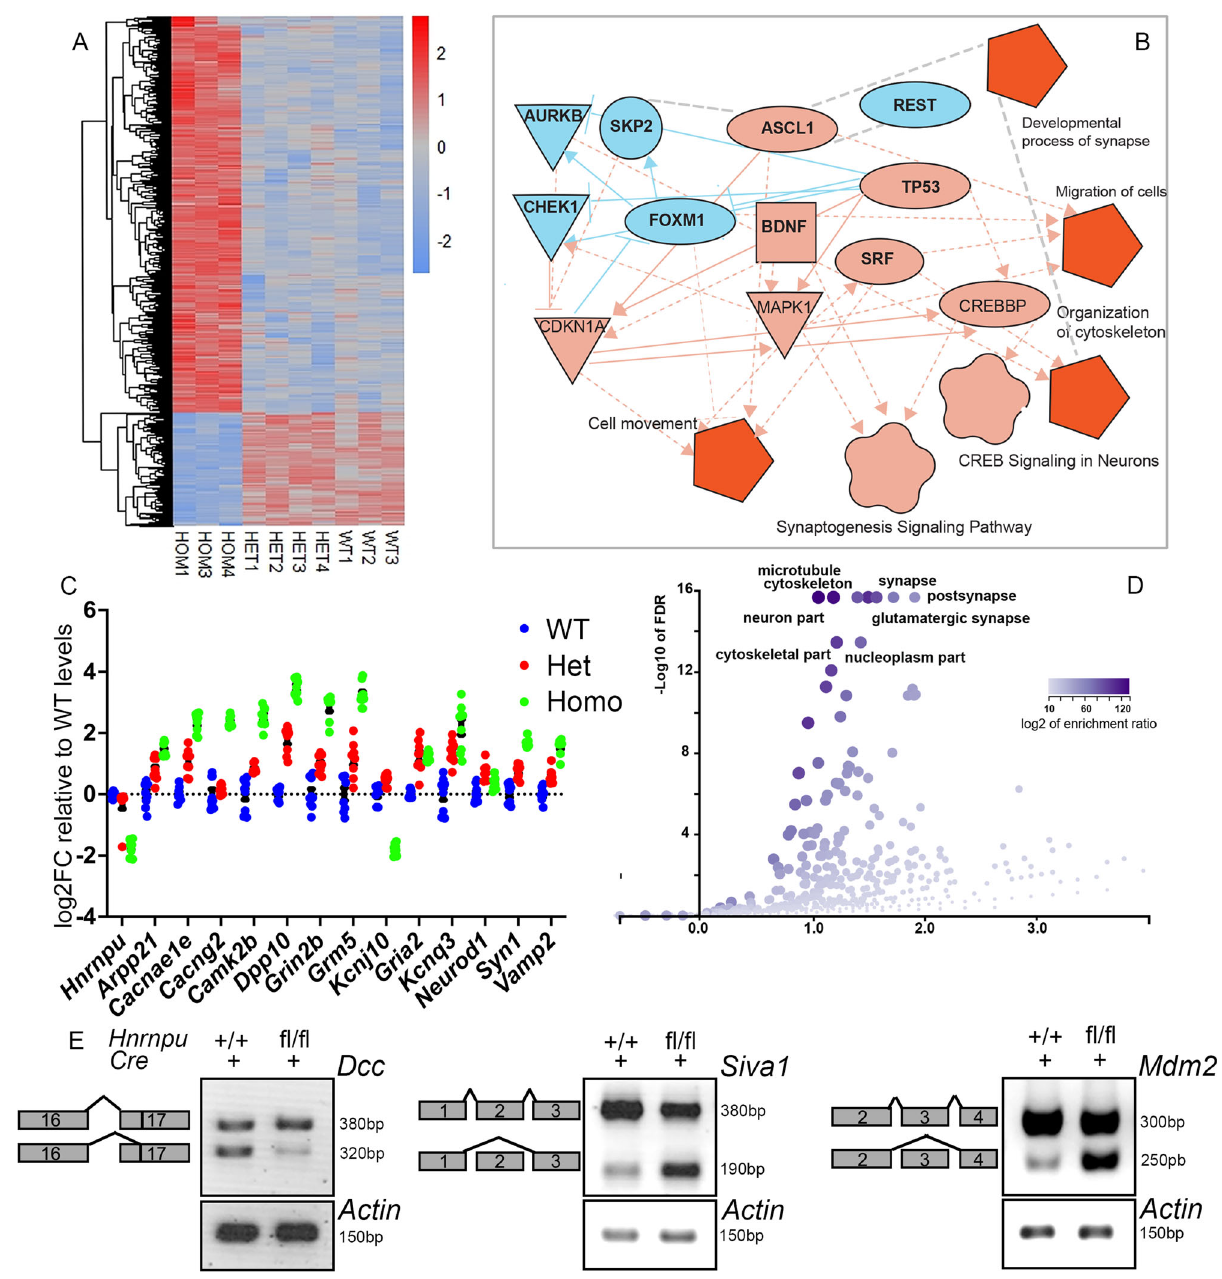
Fig. 3 Hnrnpu mutant cortices display changes in mRNA expression and alternative splicing of genes critical for brain development and function. A Hierarchical clustering of the expression of 1556 cortical DE genes in E13 control ( Hnrnpu + / + Emx1 Cre ), Mutant ( Hnrnpu fl / fl Emx1 Cre/ + ) and Heterozygous (Het, Hnrnpu fl / + Emx1 Cre/ + ) E13 mouse cortices. The expression values are represented by the log-normalized read count after the Zscore transformation. Each row is a gene. B Ingenuity analysis of RNA-seq highlighting multiple affected pathways and upstream regulators (Shape code: pentagon- function, fl ower- canonical pathway, ellipsoid- upstream regulator, triangle- kinase, square- growth factor, circle- other. Color code: light blue- downregulation, Red- strong activation, Pink- activation. lines represent interconnections between components in the network. color code: light blue- downregulation, Red- strong activation, Pink- activation). C Veri fi cation of differential expression of selected genes by qPCR in E13 cortices of control, Mutant, and Het embryos ( n = 3 biological repeats (each measured in triplicates). Error bars ± SEM. D Dysregulation of alternative splicing landscape in Hnrnpu mutant mice identi fi ed by MAJIQ. The volcano plot depicts the comparison between the mutant ( Hnrnpu fl / fl Emx1 Cre ) and the wildtype ( Hnrnpu + / + Emx1 Cre ). Enriched cellular components are indicated. E Splice variant-speci fi c PCR primers detect alternative isoforms of DCC, Siva1, and MDM2, in cDNA prepared from E13 embryo cortices of mutant ( Hnrnpu fl / fl Emx1 Cre ) and control ( Hnrnpu + / + Emx1 Cre ) littermates. Source data are provided as a Source Data fi groups representing mutant, control, and rescue (Fig. 5A, H and was observed (737). The DE genes detected in control versus Supplementary Data 3). Whereas the number of DE genes in mutant comparison were subjected to GO-term analysis. The control versus mutant comparison was 640, in the rescue versus same terms found in the RNA-seq mentioned previously were mutant comparison, a mild increase in the number of DE genes detected. Only 148 DE genes were detected in the control versus